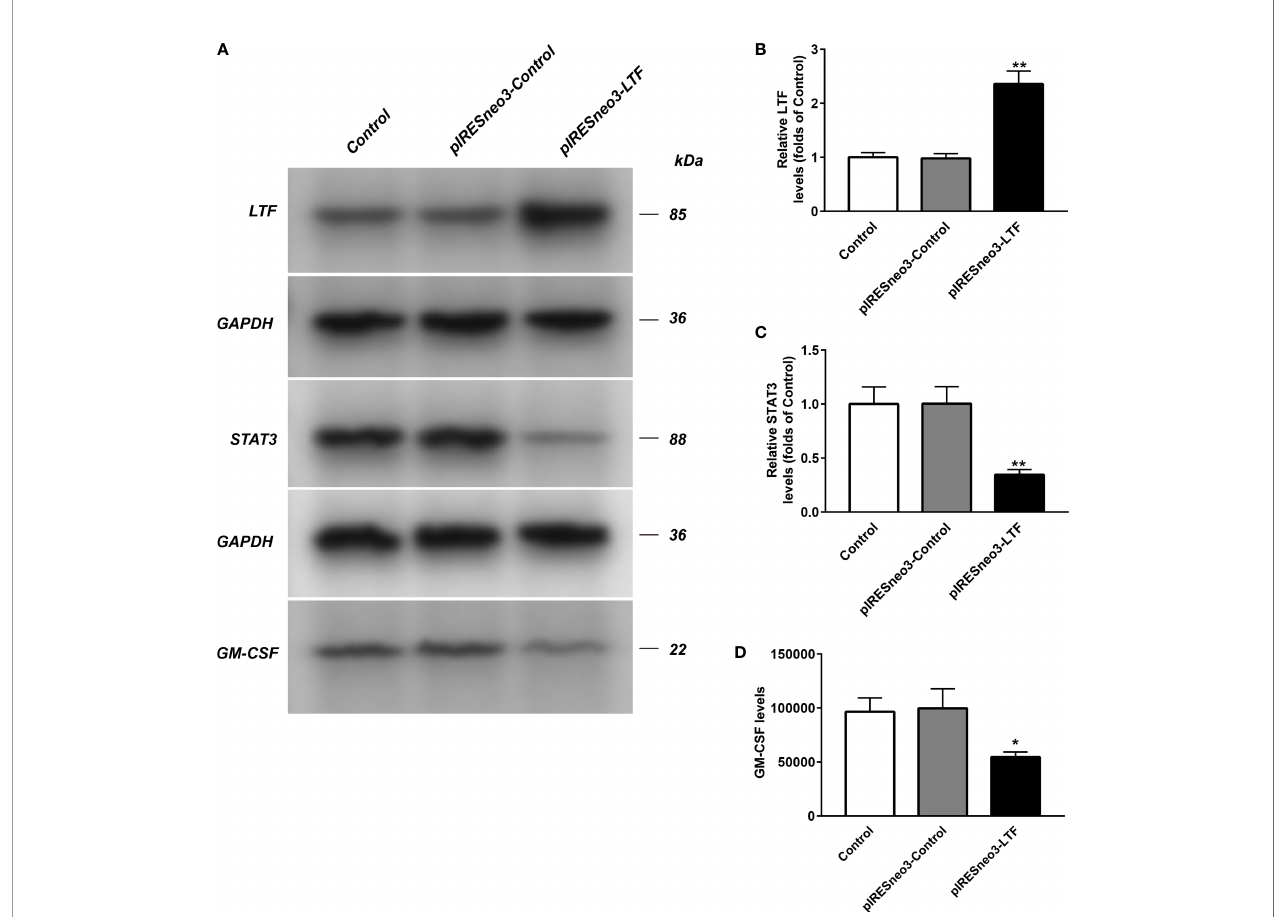
FIGURE 7 | The LTF, STAT3 and GM-CSF expressions in PC-3 from different groups were detected by western blot assay, and representative bands were shown in (A) . The levels of LTF (B) , STAT3 (C) and GM-CSF (D) were normalized to control. The results were presented as mean ± SD (n = 3). *p < 0.015, **p < 0.01 vs. pIRESneo3-Control